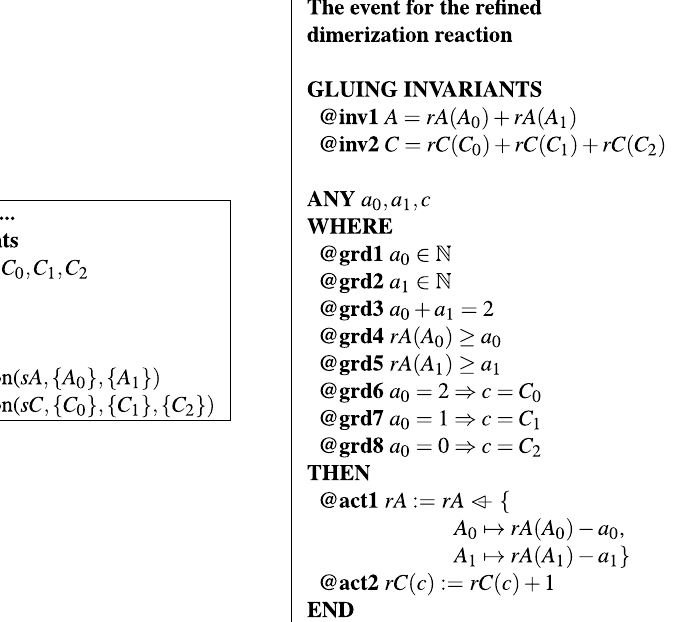
Table 3. Size-preserving refinement of a dimerization reaction in Event-B. The symbol ⊳ − is used in Event-B to specify that the function rA is modified for its arguments A 0 and A 1 .